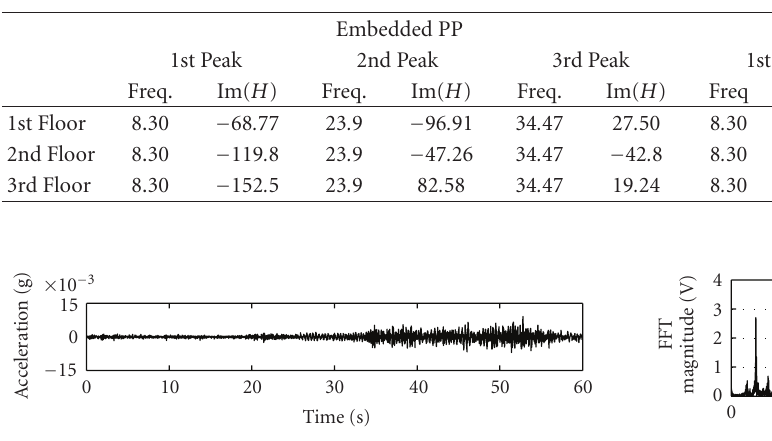
Figure 6: Locations of sensing units on the Wuyuan Bridge. Table 1: Comparison of the results by embedded PP and o ffl ine PP.